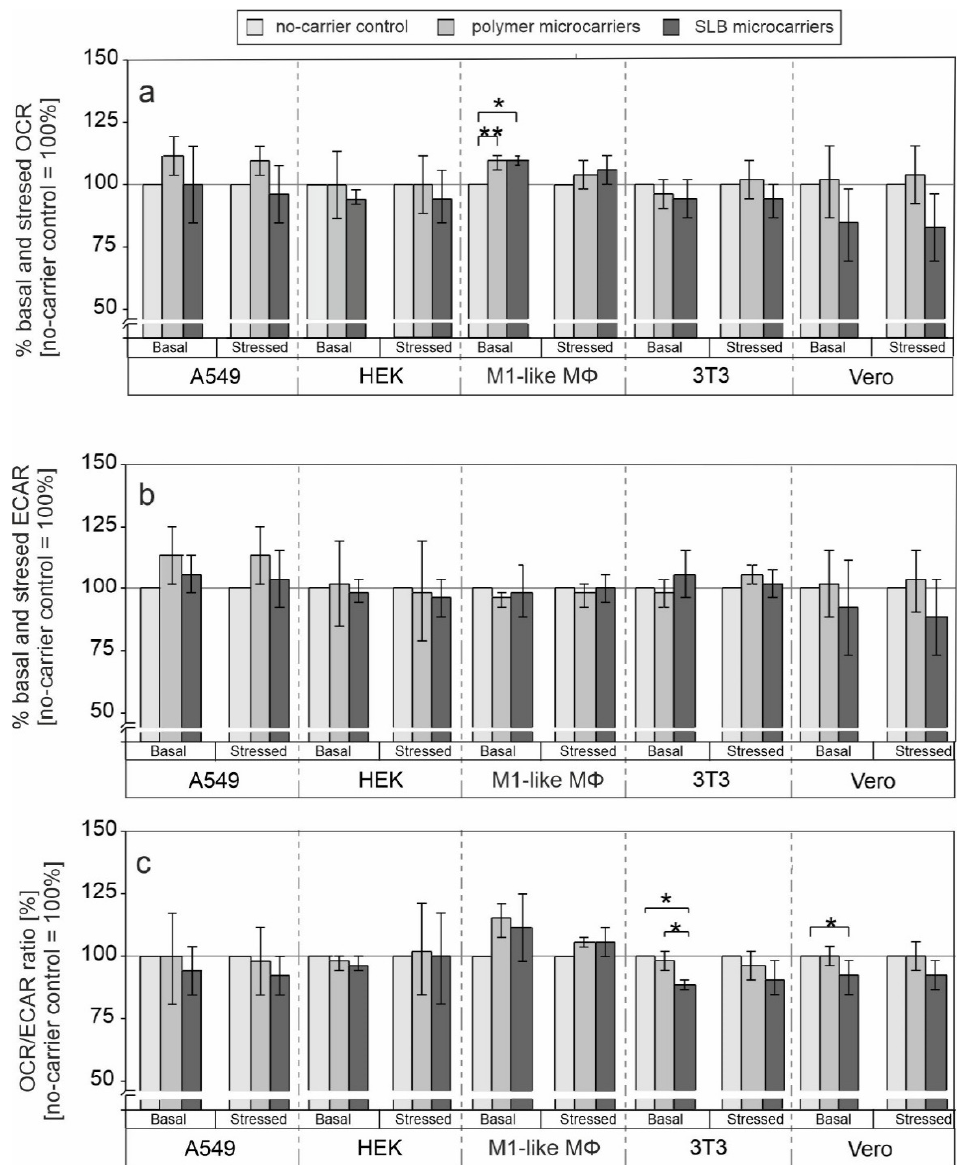
Figure 2. Influence of polymer and SLB microcarriers on mitochondrial respiration and glycolysis. The metabolic phenotype of the indicated cell lines was determined by extracellular flux analysis using the cell energy phenotype test kit. Basal and stressed ( a ) OCR and ( b ) ECAR values in addition to OCR/ECAR ratio ( c ) were obtained before and after injection of the inhibitors FCCP and oligomycin, respectively. Results are shown as percent change in relation to the untreated (no-microcarrier) control. The metabolic potential under basal and stressed (after injection of the inhibitors) conditions was calculated for indicated cell lines by the Energy Phenotype Test report generator software ( n = 3, one-way ANOVA and Tukey’s post-hoc, * p < 0.05, ** p < 0.01).